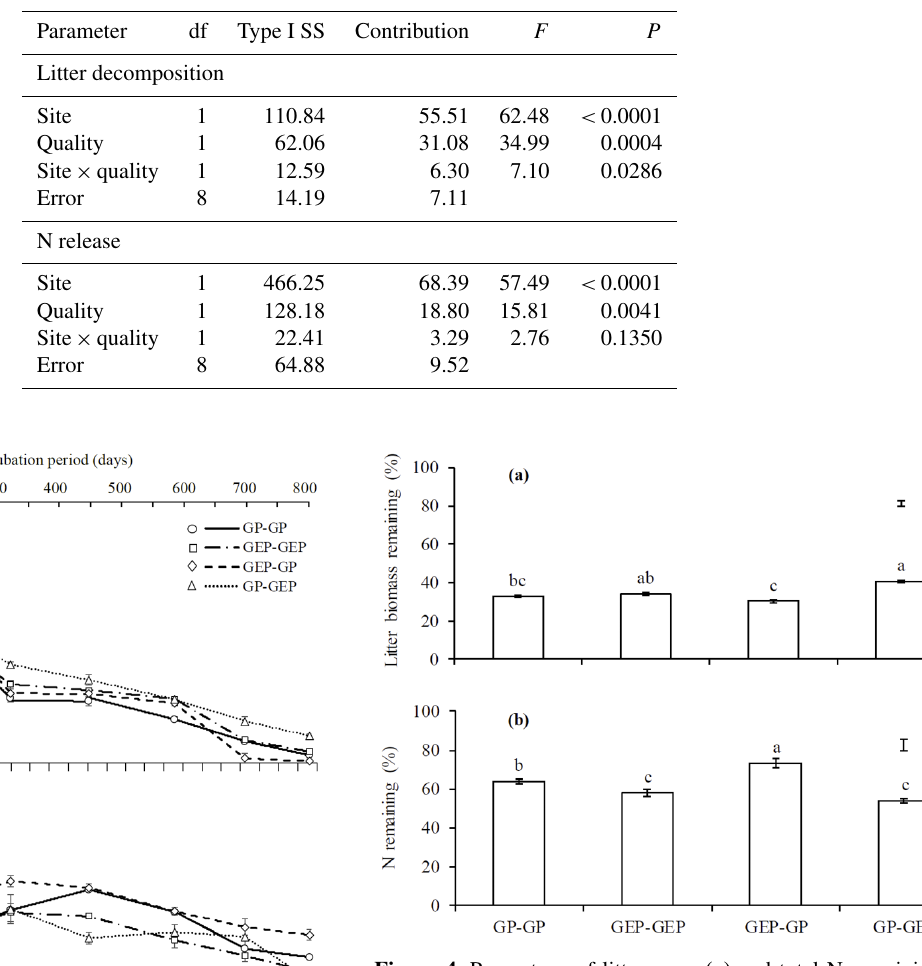
Figure 4. Percentage of litter mass (a) and total N remaining (b) at the end of experiments. GP-GP: mixed litter was collected from grazing paddocks (GP) and incubated in GP; GEP-GEP: mixed lit- ter was collected from grazing exclusion paddocks (GEP) and incu- bated in GEP; GEP-GP: mixed litter was collected from GEP and incubated in GP; GP-GEP: mixed litter was collected from GP and incubated in GEP. Vertical bars are the least significant difference (LSD) values. Columns with the different letters are significantly different (LSD test: P < 0 .